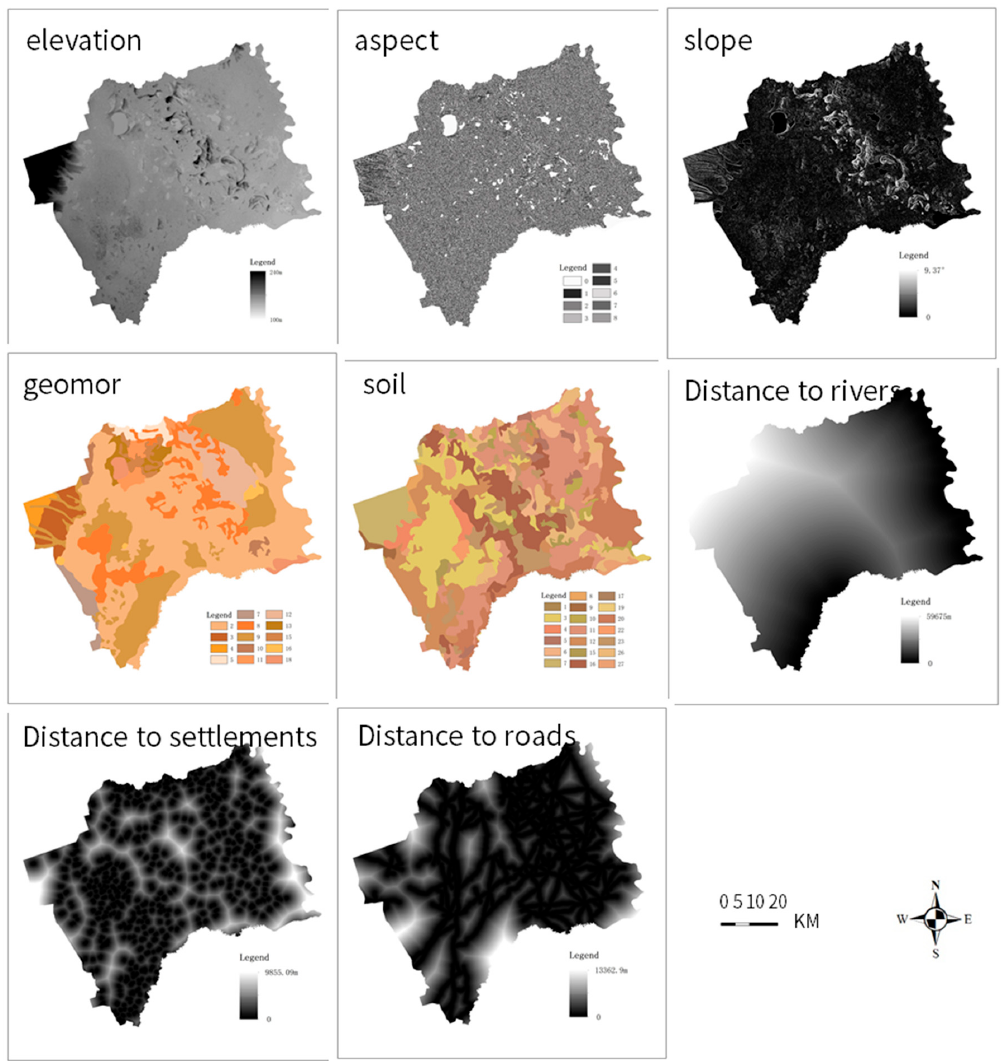
Figure 7. Visualization of natural and human geographical attributes.